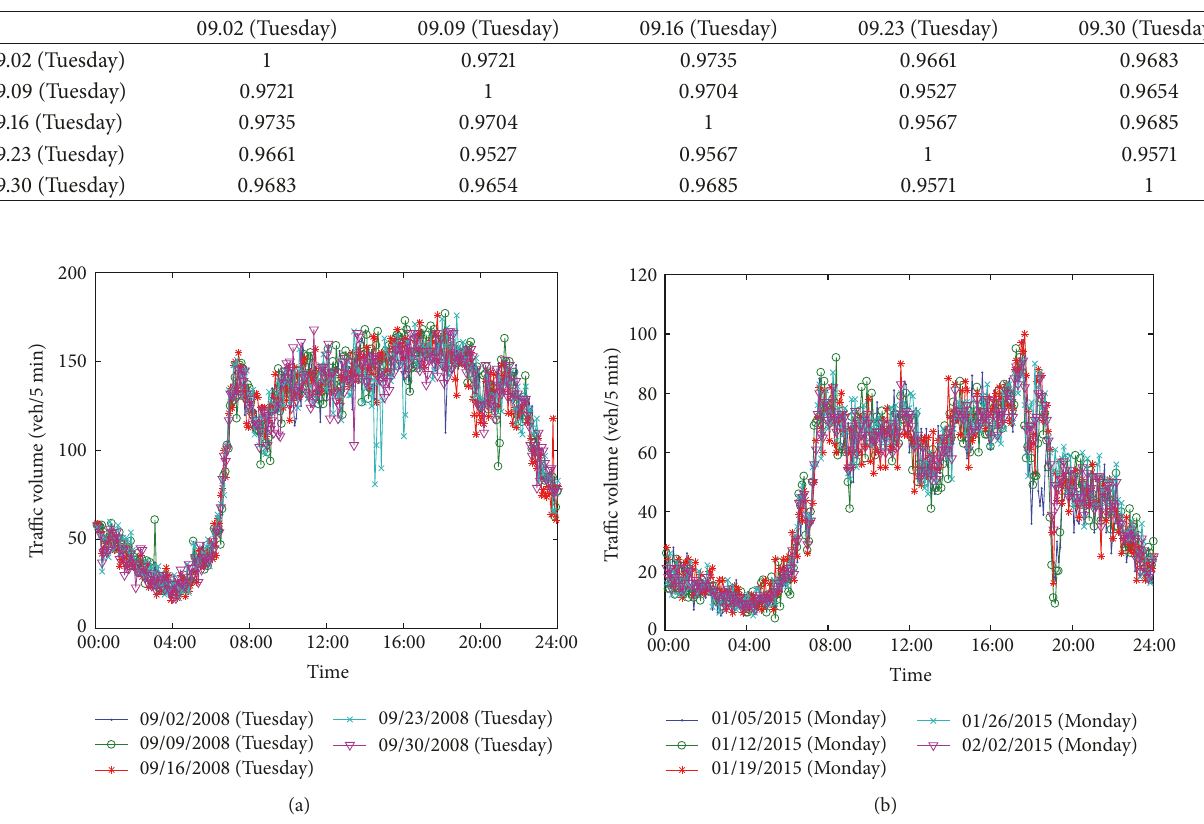
and the arterial road, respectively, whose traffic volume is used for temporal correlation